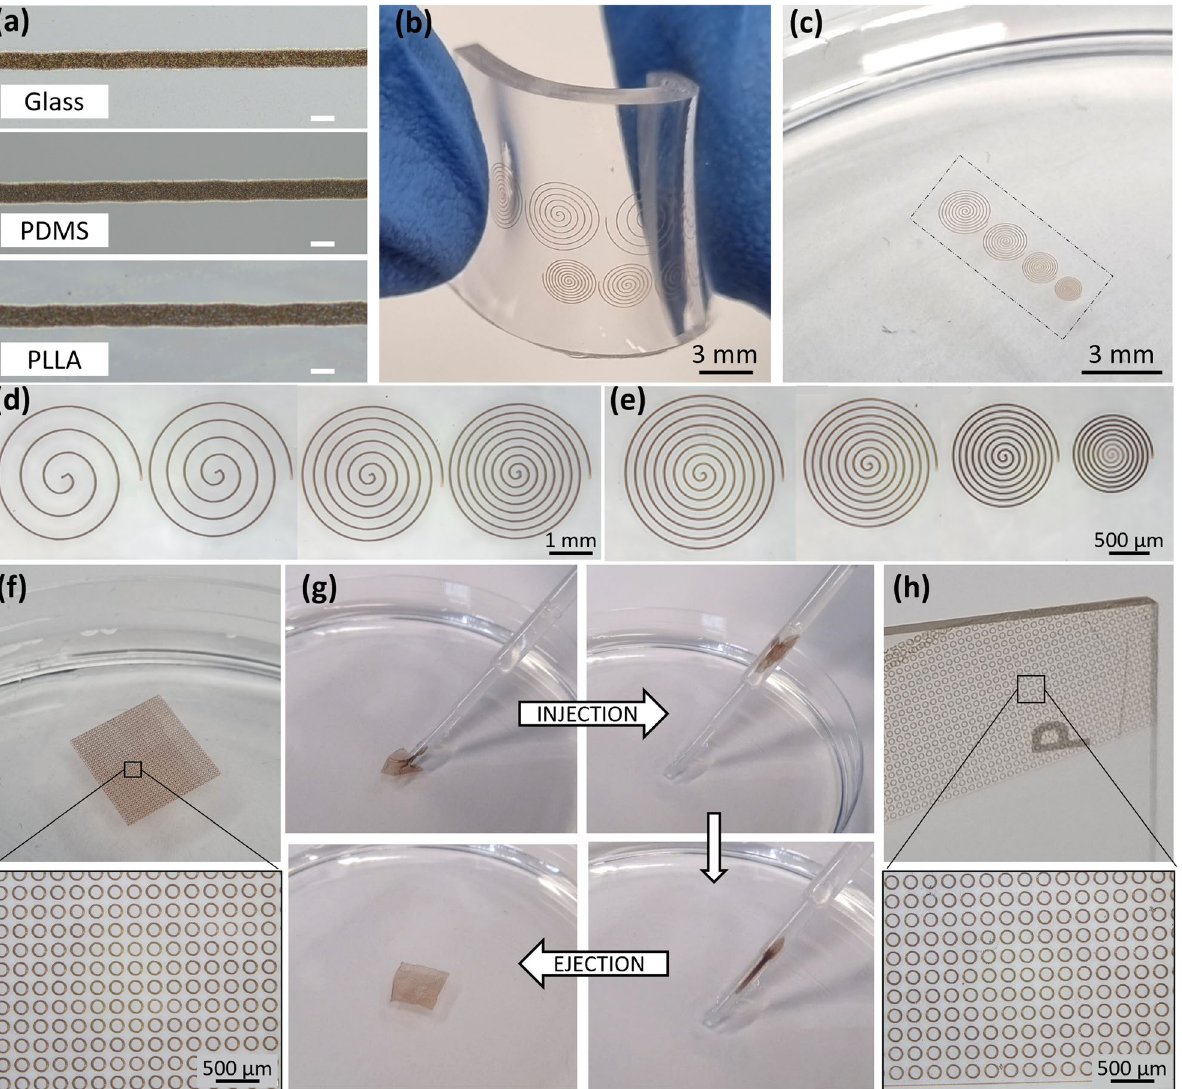
Figure 6. ( a ) Comparison of optical microscopic micrographs of SPIONs lines printed on top of a glass slide, a PDMS film and a PLLA nanofilm (carrier gas flow 10 SCCM, sheath gas flow 40 SCCM, FR = 4). Scale bar 20 µm. ( b ) A PDMS film with patterned surface. ( c ) A patterned PLLA nanofilm floating over the water surface after the release from the fabrication substrate (the edges of the nanofilms are highlighted by a dashed line). Optical microscopic images of spirals with different pitch and external radius printed on PDMS ( d ) and PLLA ( e ). ( f ) Released patterned nanofilm (15 mm × 15 mm) floating over the water surface and optical microscope magnification. ( g ) Patterned nanofilm injection (top) and ejection (bottom) sequence. ( h ) Patterned nanofilm collected and dried on a glass slide and optical microscope magnification after 10 injection and ejection